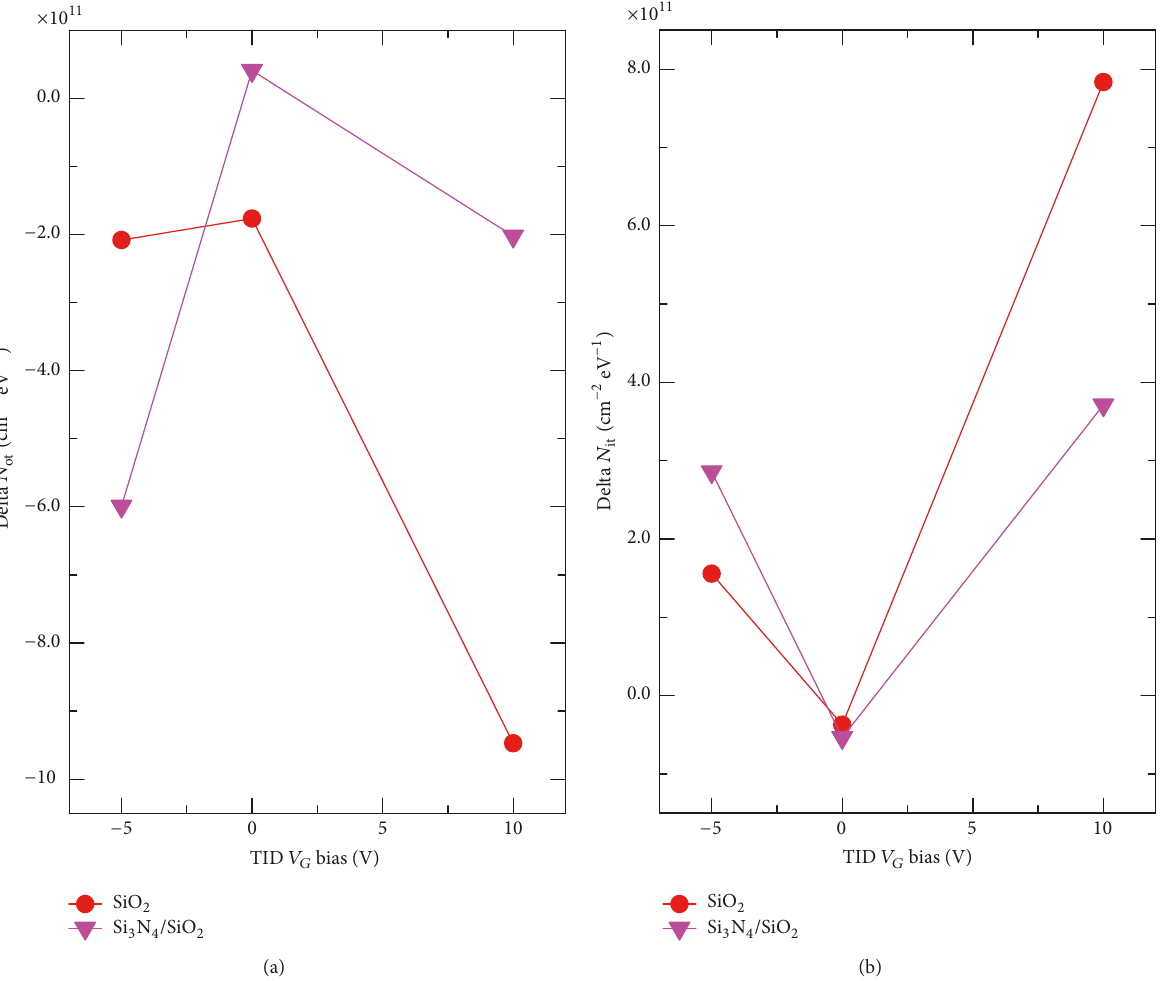
Figure 4: (a) Δ𝑁 and (b) Δ𝑁 characteristics of Si VDMOS with both single SiO 2 and double Si 3 N 4 /SiO 2 gate dielectrics after different TID ot it bias